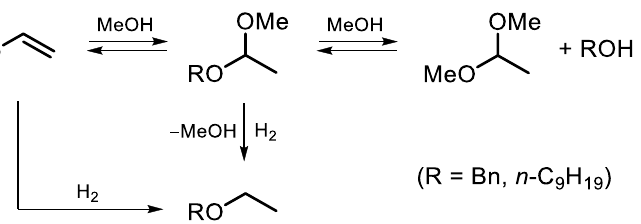
Scheme 2. Proposed reaction scheme for the hydrogenation of BVE and NVE over Pd/C catalysts in MeOH